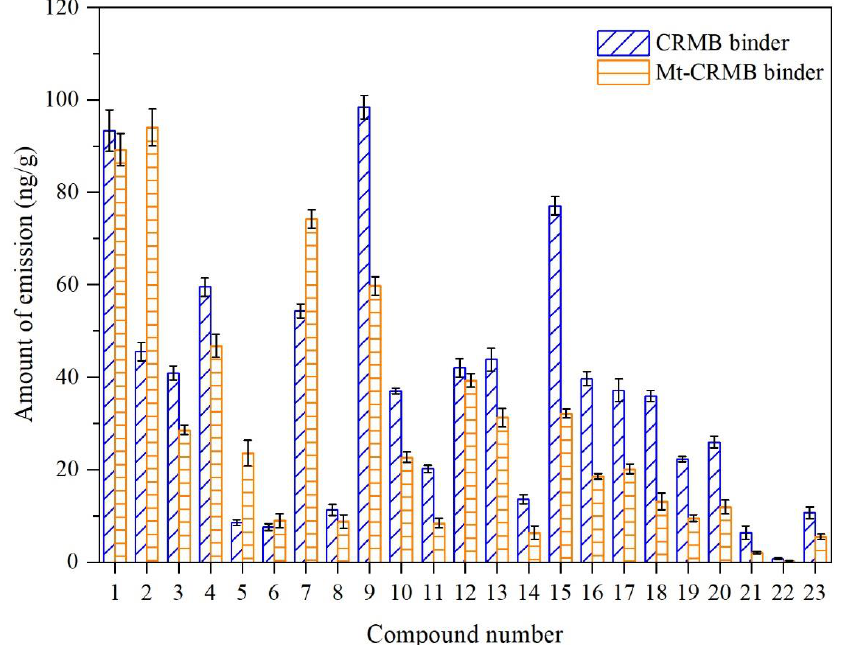
Figure 8. Emission amount comparison of each VOC fingerprint compound between CRMB and Mt-CRMB binders. Mt-CRMB